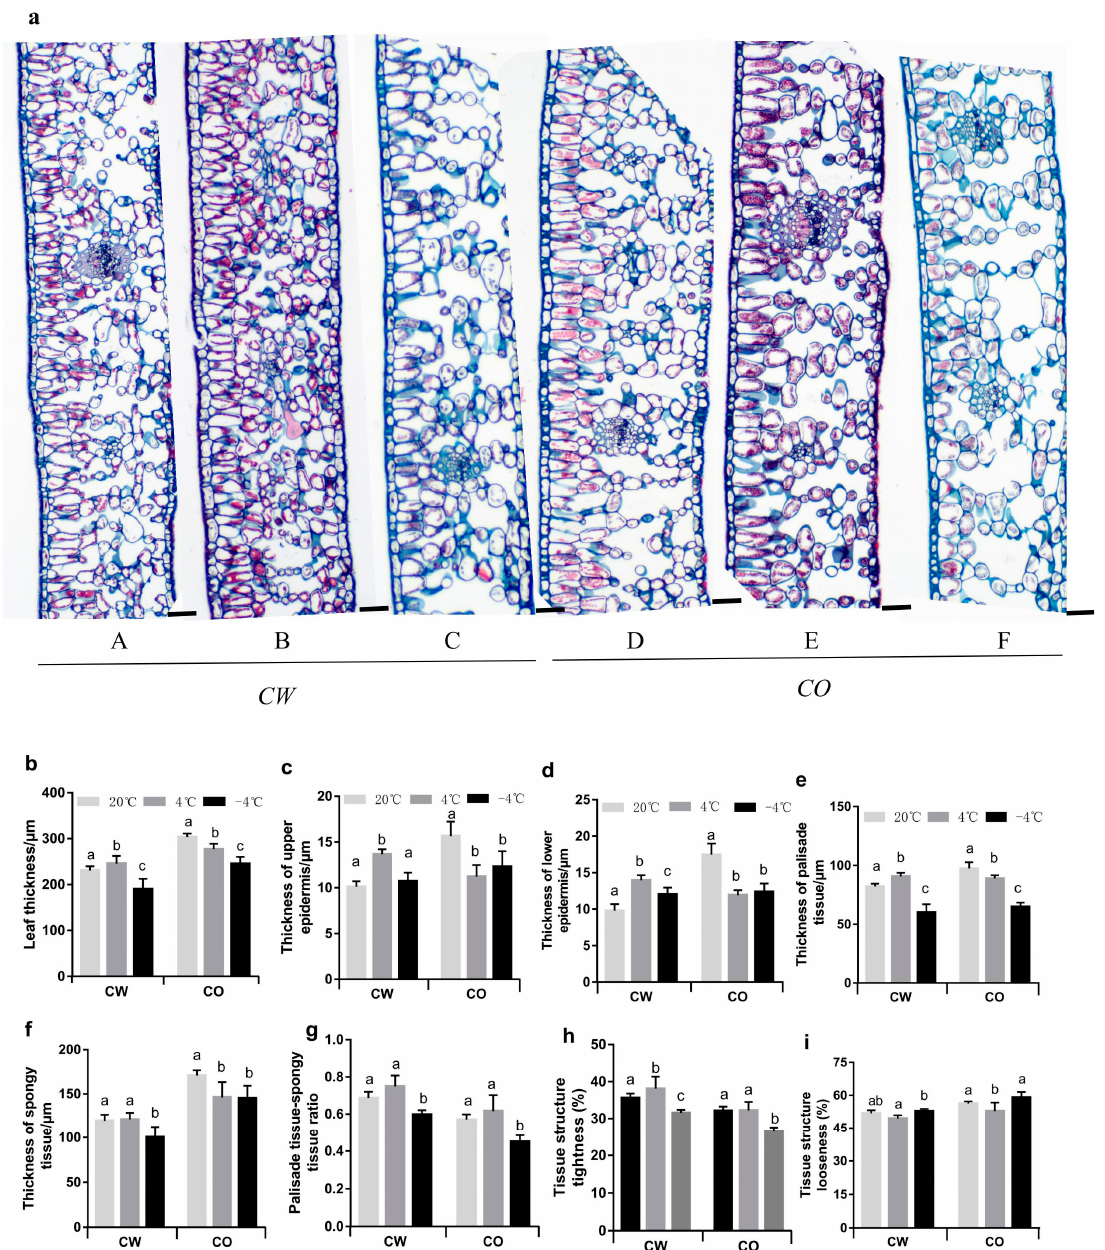
Figure 1. Effects of different temperatures on leaf anatomical structure of two Camellia species. ( a ) The representative pictures of C. weiningensis (CW) and C. oleifera (CO) seedlings, Scale = 50 µ m; A, CW treated with 20 ◦ C; B, CW treated with 4 ◦ C; C, CW treated with − 4 ◦ C; D, CO treated with 20 ◦ C; E, CO treated with 4 ◦ C; F, CO treated with − 4 ◦ C. ( b – i ) Determination of leaf anatomic structure indexes, ( b ) leaf thickness, ( c ) thickness of upper epidermis, ( d ) thickness of lower epidermis, ( e ) thickness of palisade tissue, ( f ) thickness of spongy tissue, ( g ) palisade tissue-spongy tissue ratio, ( h ) tissue structure tightness, ( i ) tissue structure looseness. Six plants of each of the two species from cold treatment and control were used for the measurements, five images per plant were taken. Different letters in each species indicate significant differences among different temperature treatments ( p < 0.05).